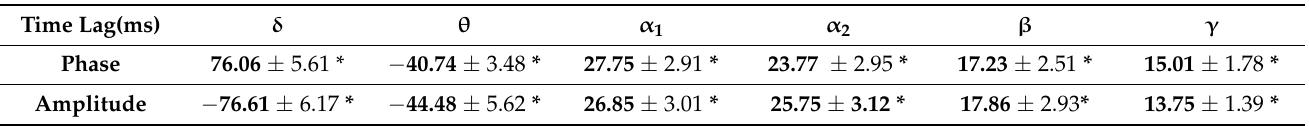
Table 2. Subject-averaged PAI time-lag estimation between posterior–anterior cortical areas based on dSTE.